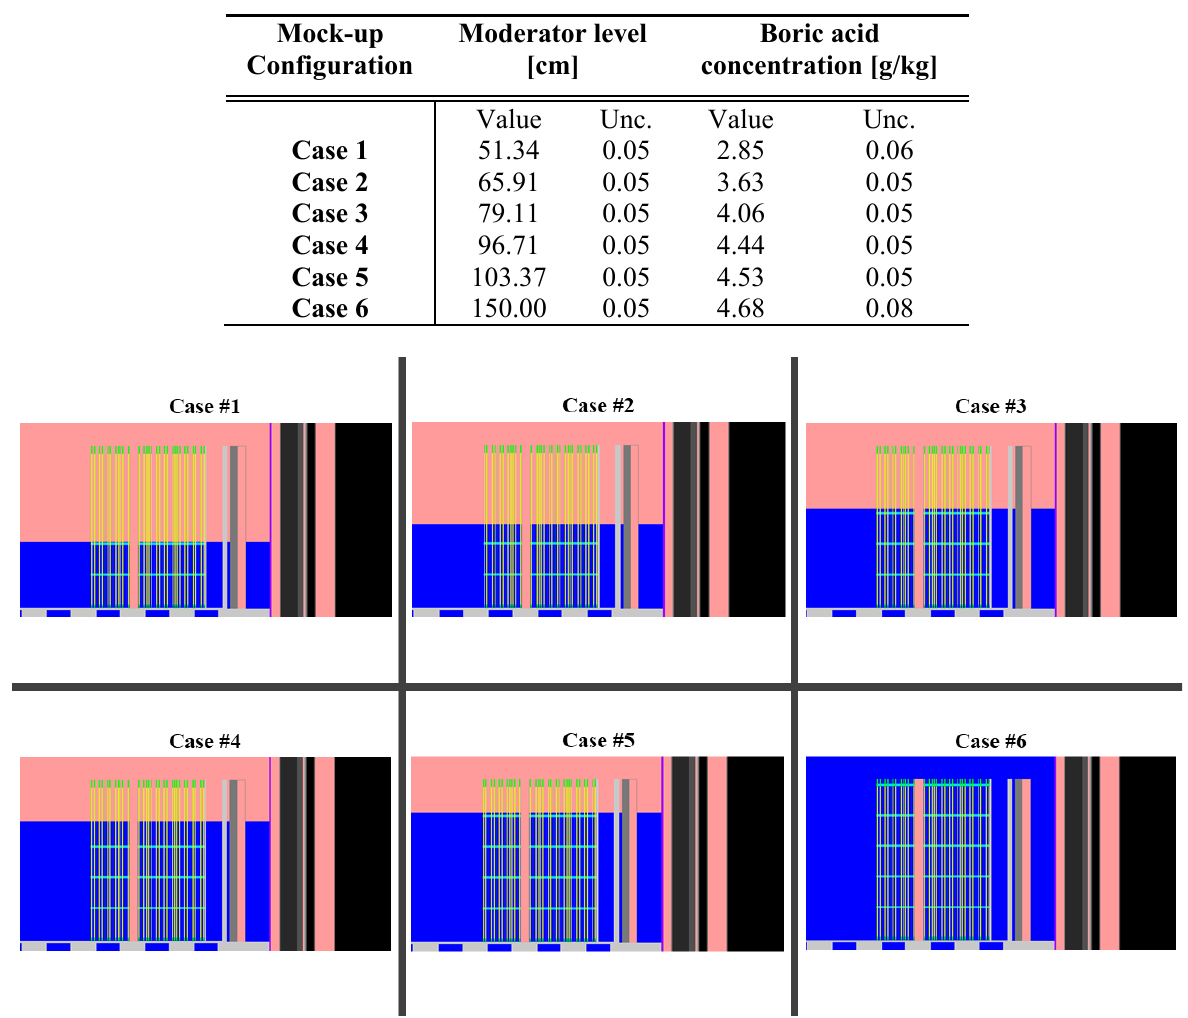
Table I. Critical configurations of the VVER-1000 mock-up